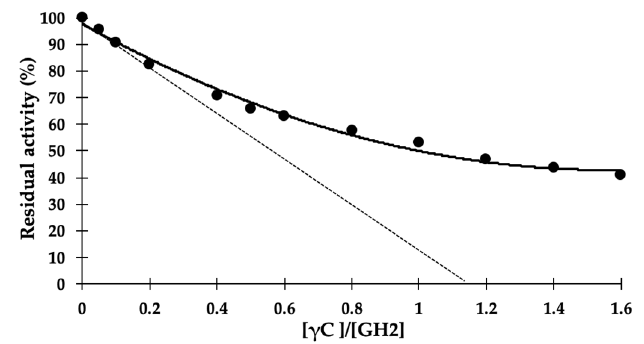
Figure 5. Titration curve of GH2 β-mannosidase with γC. Increasing concentrations of γC were added to a fixed concentration of enzyme (11.8 μM). Residual enzyme activity is expressed as percentage activity compared with the enzyme alone, using pNP-β-D-mannopyranoside as the substrate (0.8 mM), at pH 6.0, in the presence of 1 mM Zn 2+ . Each point is the mean of three assays. Error bars have been omitted for better clarity. The best fit curve (black full line) has R² = 0.9913. The x-intercept value of the traced tangent line (dash line) indicates an inhibitor/enzyme stoichiometry of 1.14.